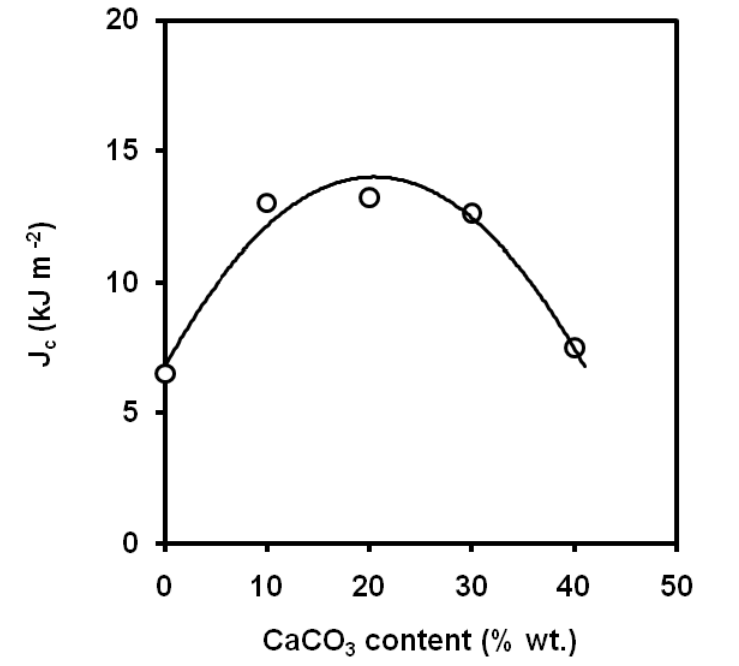
content on the values of J 3